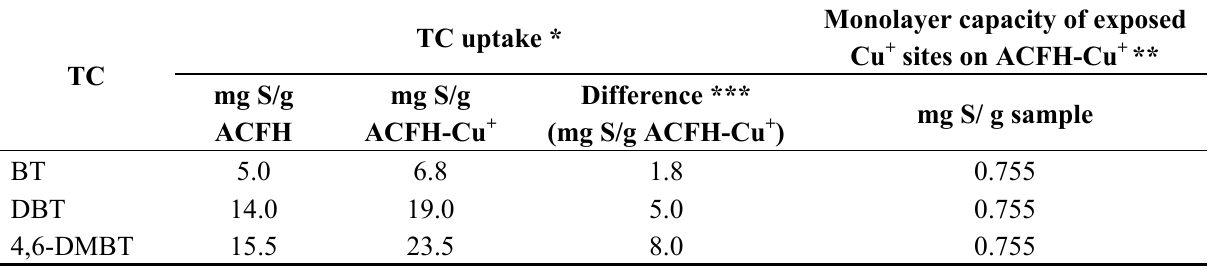
Table 4. A comparison of estimated monolayer adsorption capacities of TC on Cu+ sites and experimental TC uptakes. Monolayer capacity of exposed TC uptake * Cu + sites on ACFH-Cu + ** TC mg S/g mg S/g Difference *** mg S/ g sample ACFH ACFH-Cu + (mg S/g ACFH-Cu + ) BT 5.0 6.8 1.8 0.755 DBT 14.0 19.0 5.0 0.755 4,6-DMBT 15.5 23.5 8.0